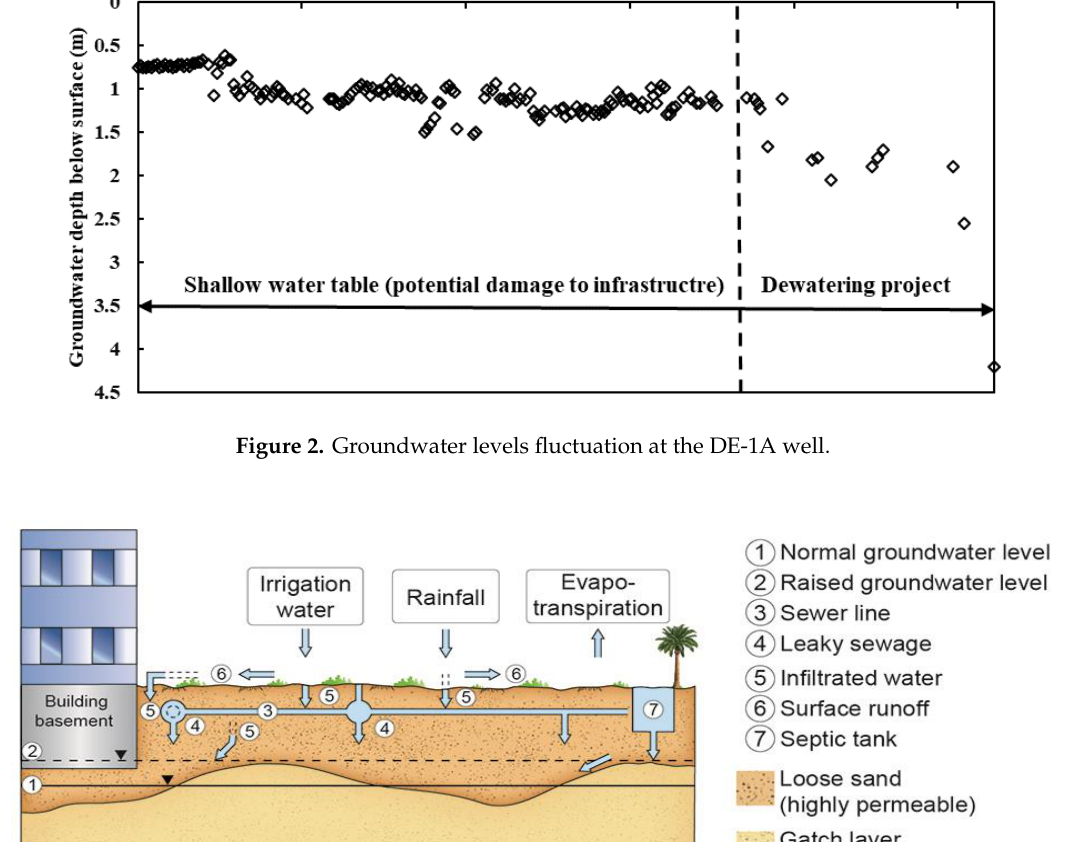
Figure 2. Groundwater levels fluctuation at the DE-1A well.